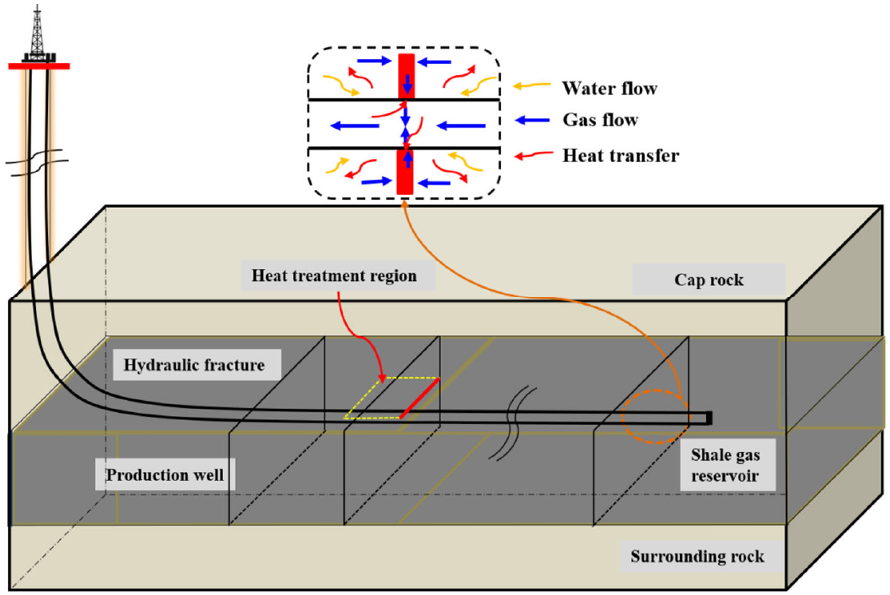
Figure 1. Electrofrac technical sketch of shale ‐ gas recovery based on hydraulic fracture heating (modified from Liu et al. [16]).